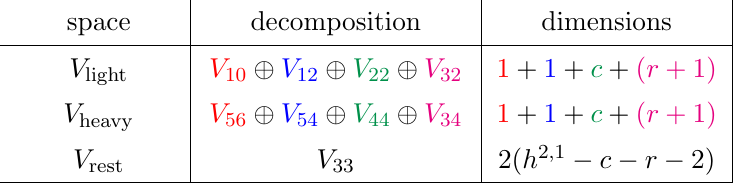
Table 6 . Decomposition of H 3 ( Y 3 ; R ) for III c ! IV d